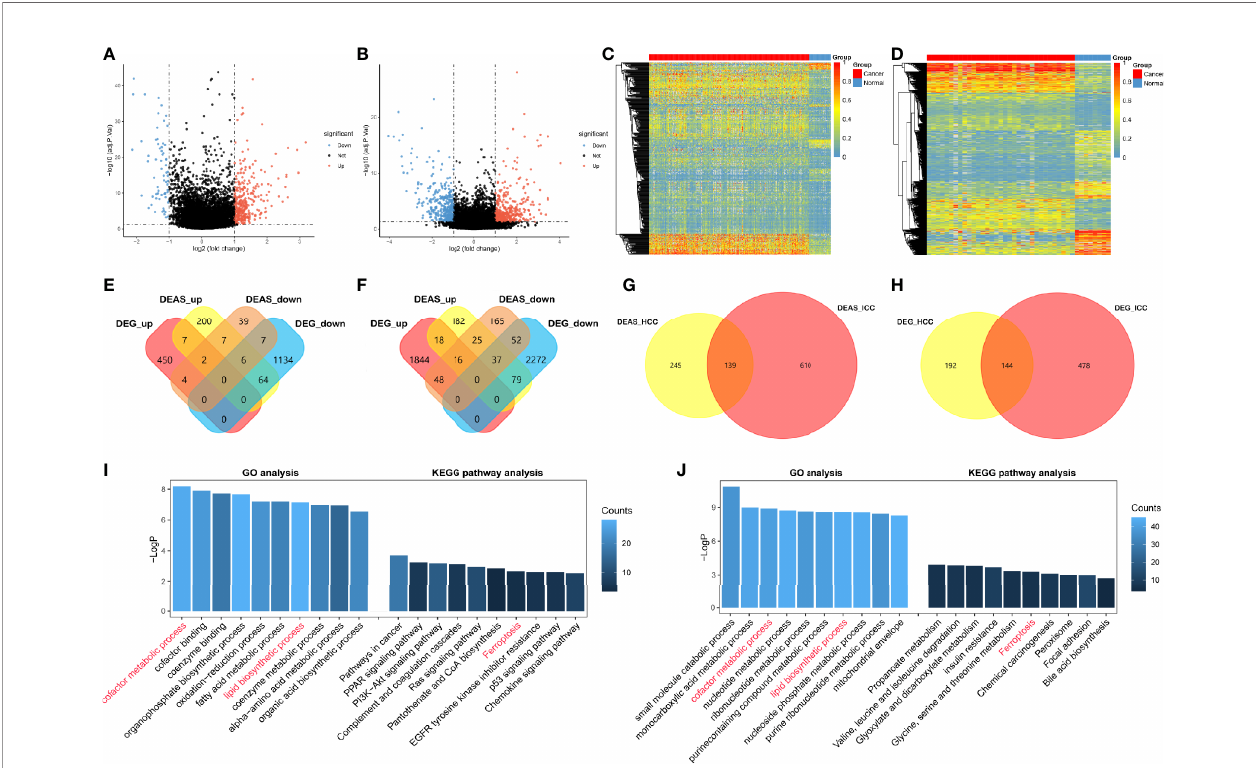
FIGURE 3 | Identi fi cation of DEAS events and potential functional analyses in HCC and ICC. (A, B) The tumor-speci fi c AS events between tumor tissues and normal tissues. DEAS events identi fi ed in HCC (A) and ICC (B) . (C, D) Heatmaps of the DEAS events in HCC (C) and ICC (D) , respectively. (E, F) Two Venn diagrams showed the common of DEAS events (yellow and orange) and DEG (red and blue) among HCC (E) and ICC (F) . (G, H) Two Venn diagrams were generated to show the common of DEAS events (G) and DEG (H) between HCC (yellow) and ICC (red). (I, J) GO, KEGG pathway etc. analyses of DEAS events in HCC (I) and ICC (J) ; the x axis represents the annotations of GO or KEGG pathway etc.; the y axis re fl ects the number of corresponding